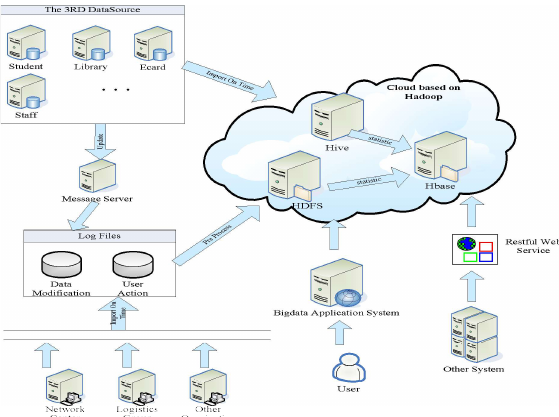
Figure 1. Platform